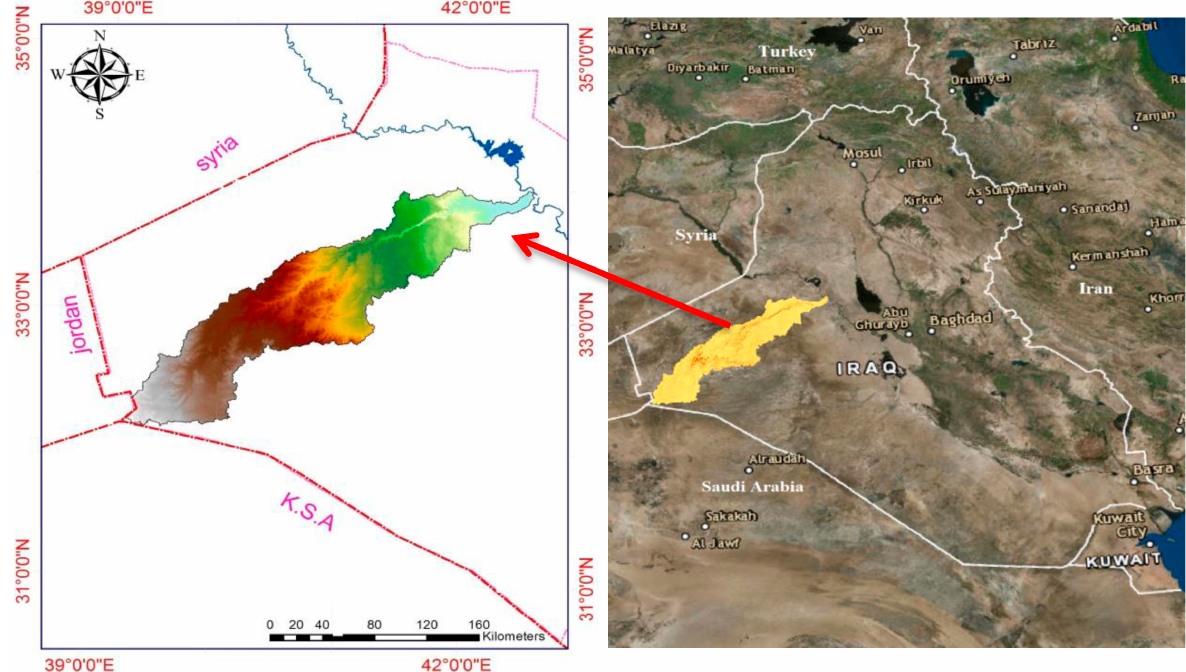
Figure 1. Study area, showing the Al-Abila dam location after [3] .